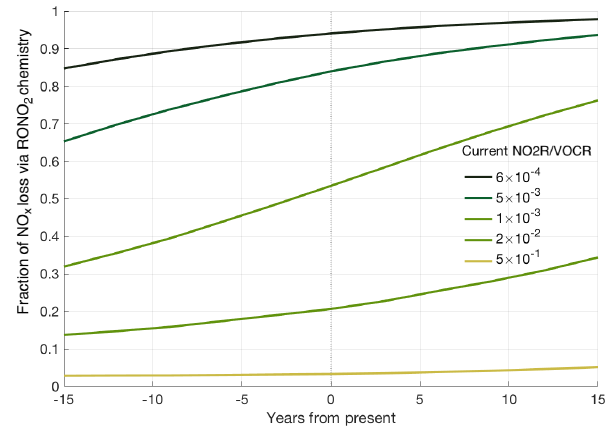
Figure 5. Predicted trends in fractional NO x loss over time, cal- culated from the estimated NO2R / VOCR ratio assuming a con- stant 6 . 5%yr − 1 decrease in anthropogenic VOC concentrations, a 5.5%yr − 1 decrease in NO x concentrations, and a 1.5%yr − 1 in- crease in biogenic VOC